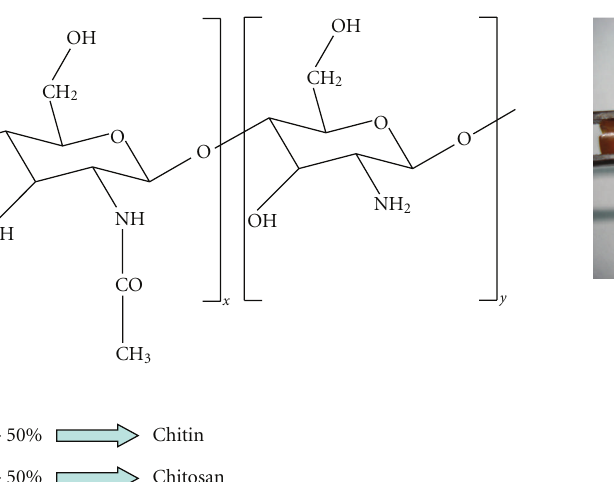
Figure 1: Molecular structures of chitin and CS.